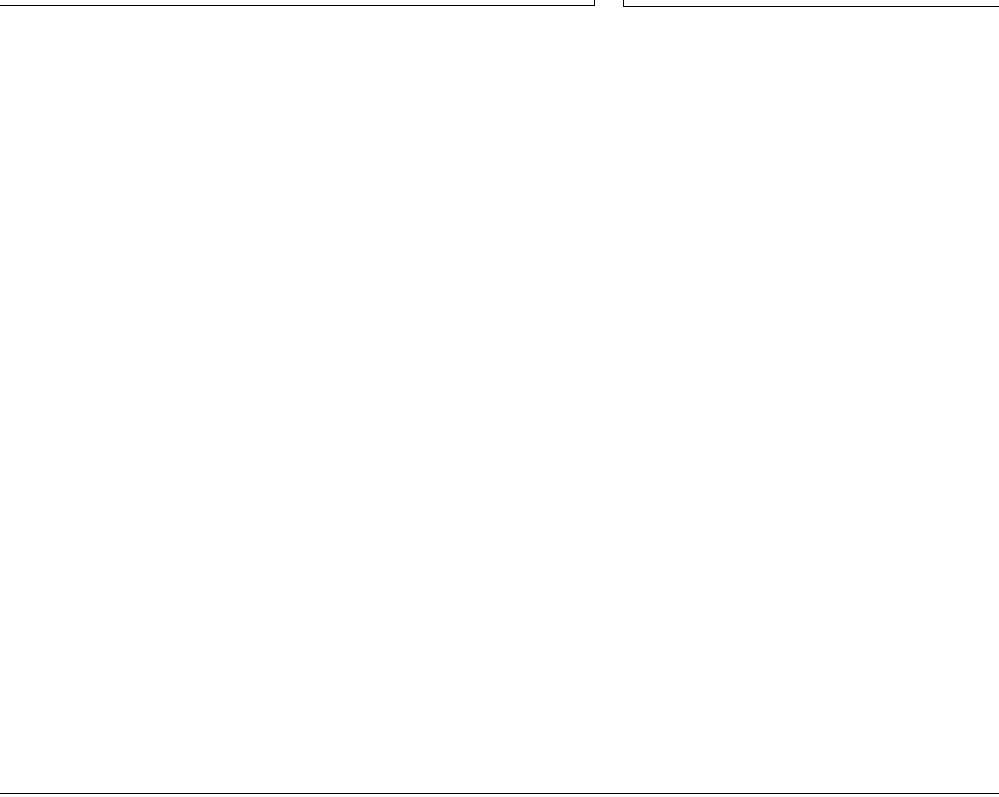
FIGUREA2 | Prediction of membrane localization. TOPCONS single was used to predict transmembrane helices.The percentage of identified proteins for the different pools as described in Figures 1D,E is presented. Shown are the results for all proteins identified by more than one peptide (black) and for all identified